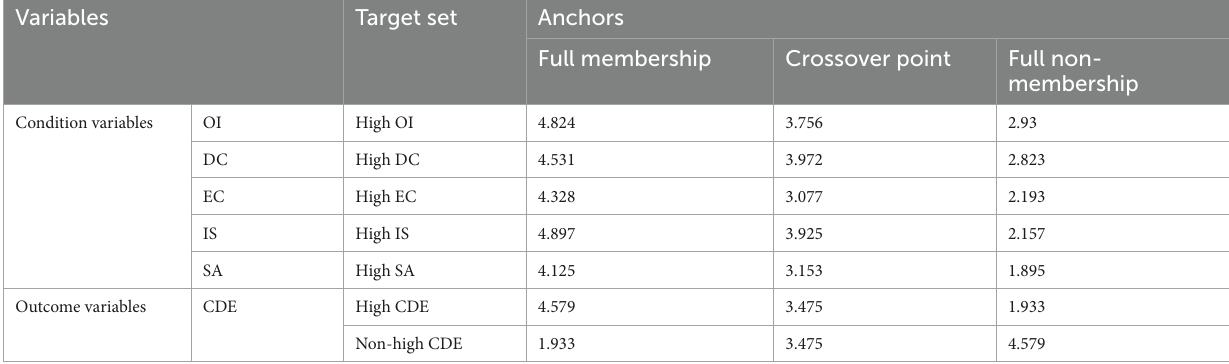
TABLE 6 Calibration anchors for each